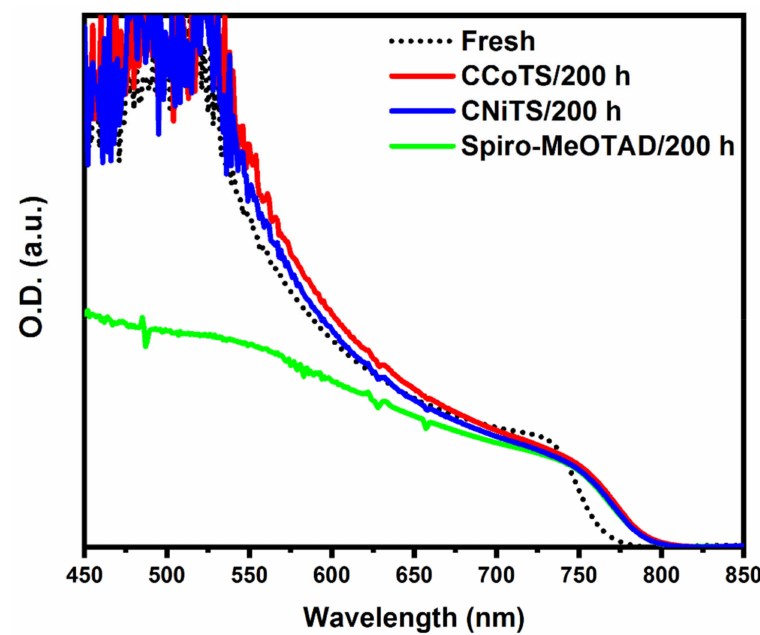
Figure 5. UV-Vis absorption spectra of perovskite-coated CCoTS, CNiTS and spiro-MeOTAD after 200 h of light soaking under AM 1.5 simulated solar light in ambient air (50% relative humidity).